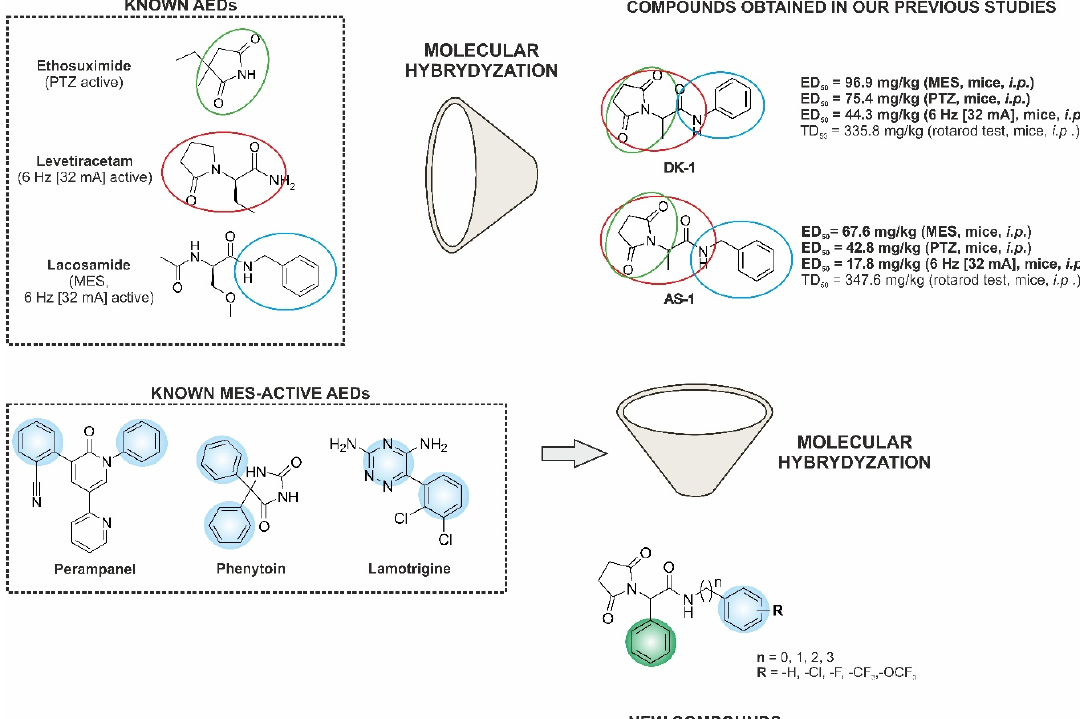
Figure 1. Design and general structure of hybrid 2-(2,5-dioxopyrrolidin-1-yl)-2-phenylacetamide derivatives (the main modification site is marked in green).